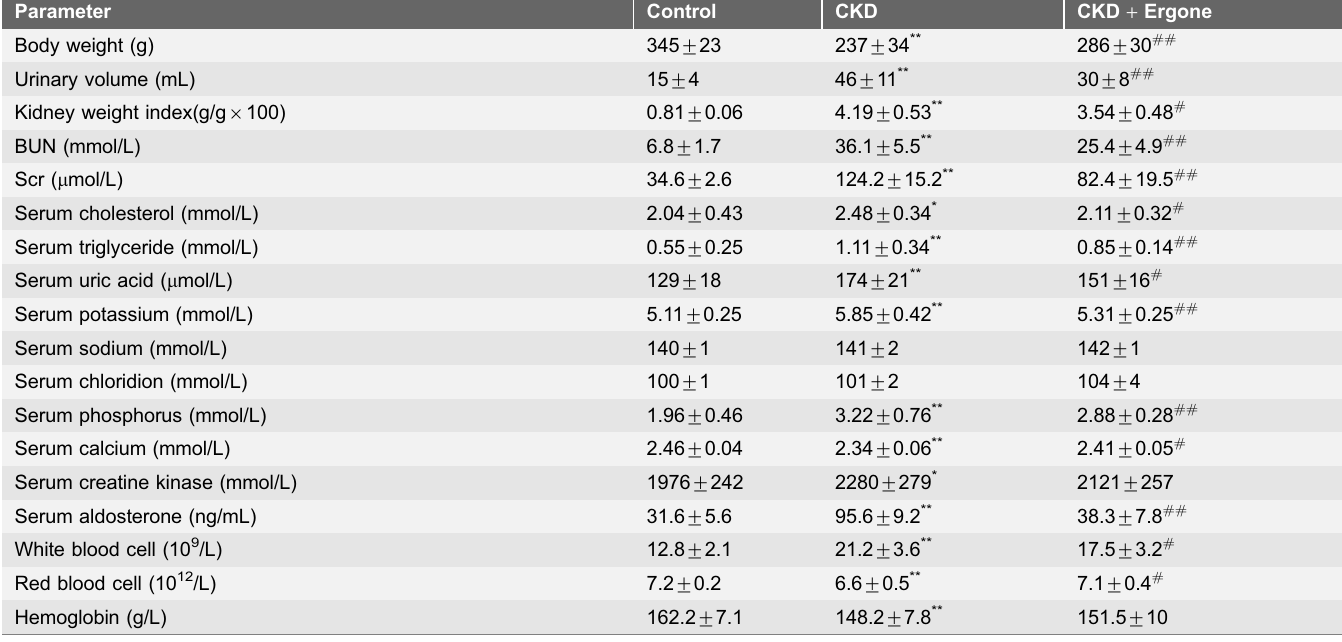
Table 1. Physiologic parameters of